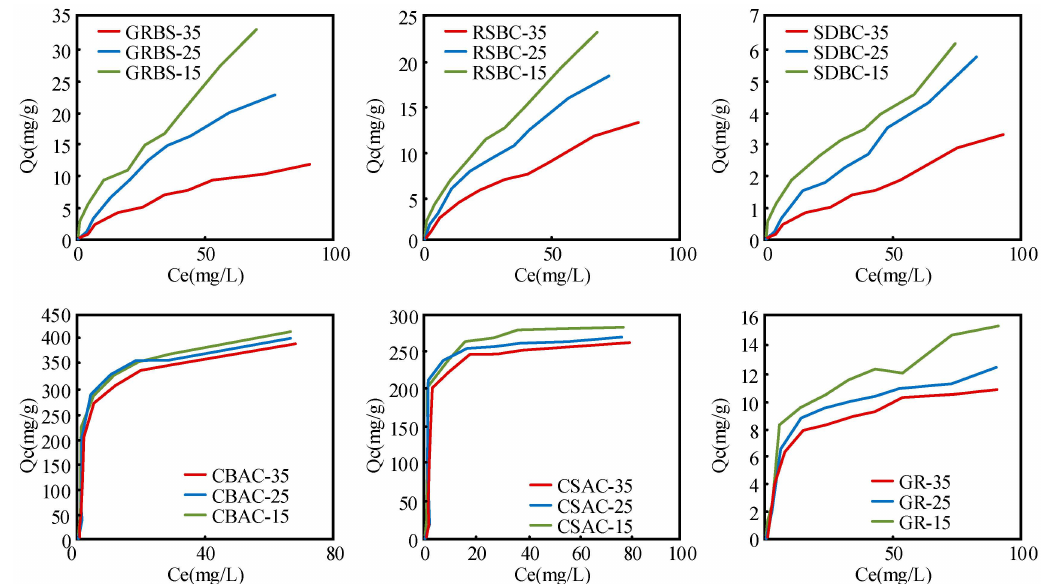
Figure 3. Effect of temperature on DEP adsorption onto